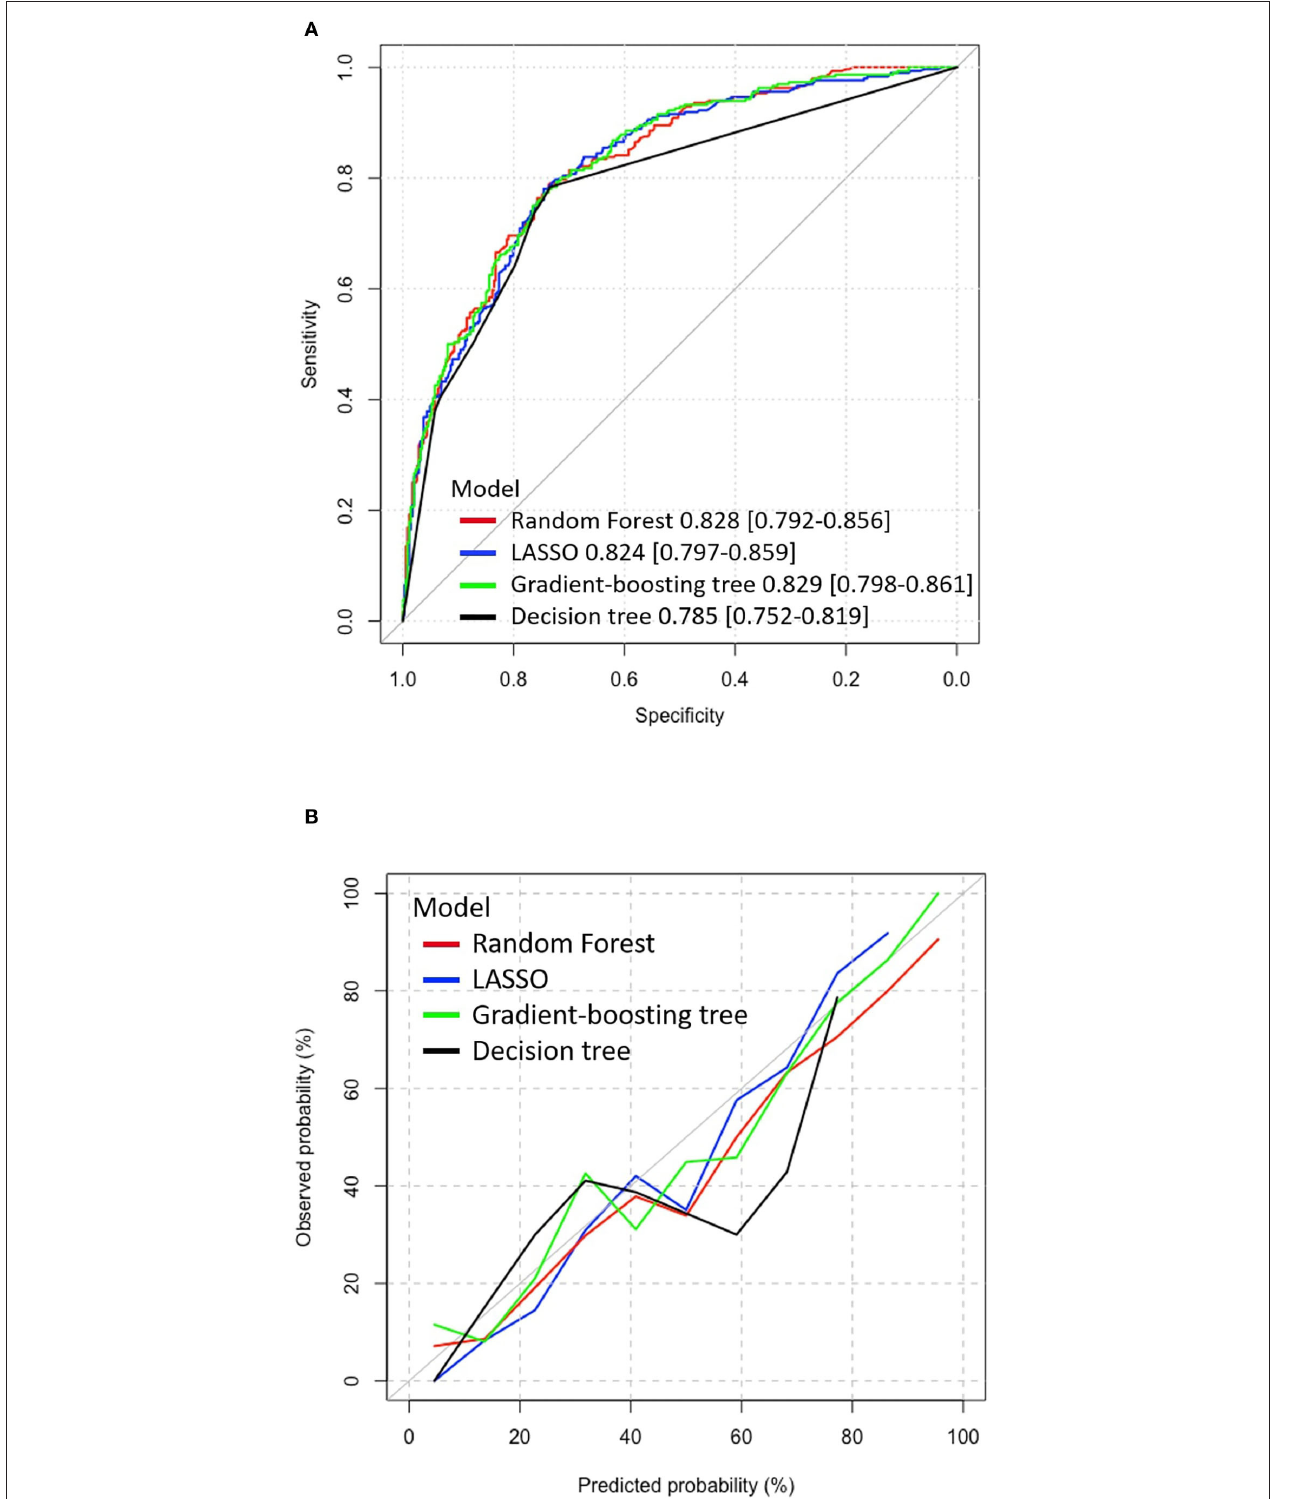
FIGURE 3 | ROC curve and calibration plot of models in the test dataset. (A) The ROC curve of the models, X -axis: specificity, Y -axis: sensitivity. The AUC [95% CI] of the models; random forest: 0.828 [0.792–0.856], logistic regression with LASSO: 0.824 [0.797–0.859], gradient-boosting tree: 0.829 [0.798–0.861], and decision tree: 0.785 [0.752–0.819]. (B) Calibration plot, X -axis: probabilities estimated by machine learning models, Y -axis: observed probabilities of outcome. ROC, Receiver operating characteristic; AUC, Area under the curve; LASSO, Absolute shrinkage and selection operator.